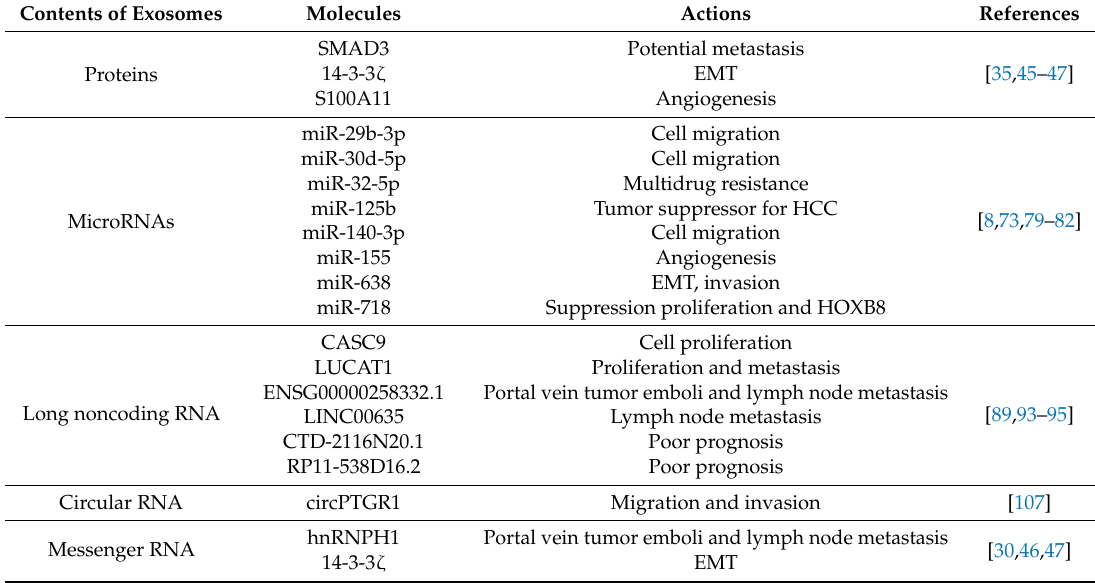
Table 2. Exosomal biomarkers for the prediction of survival of patients with hepatocellular